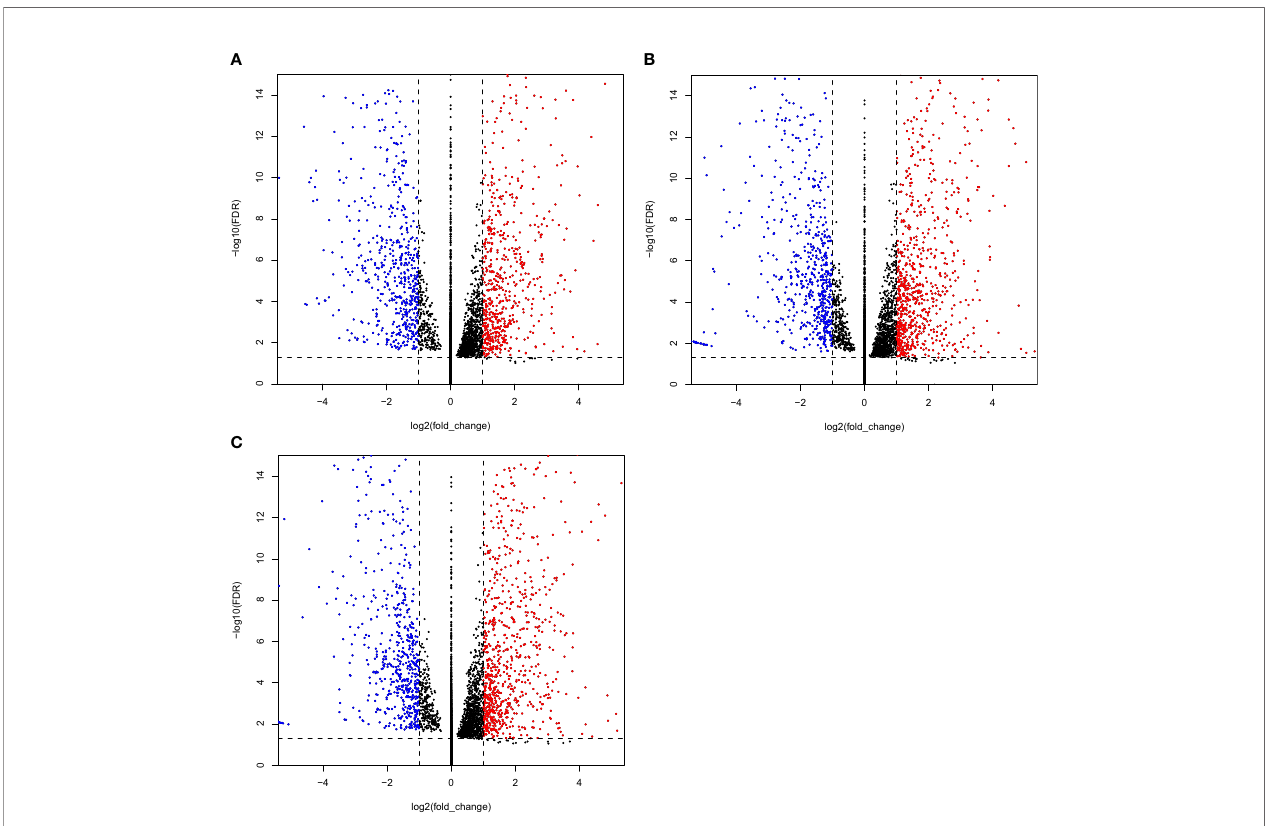
FIGURE 1 | Volcano plots of the differentially expressed genes (DEGs) MCF-7 cell lines were treated with three candidate medicines. (A) R. communis L. , (B) E. cochinchinensis Lour ., (C) B . fruticose . The horizontal line at |log2FC| = 1; vertical line at false discovery rate (FDR) =